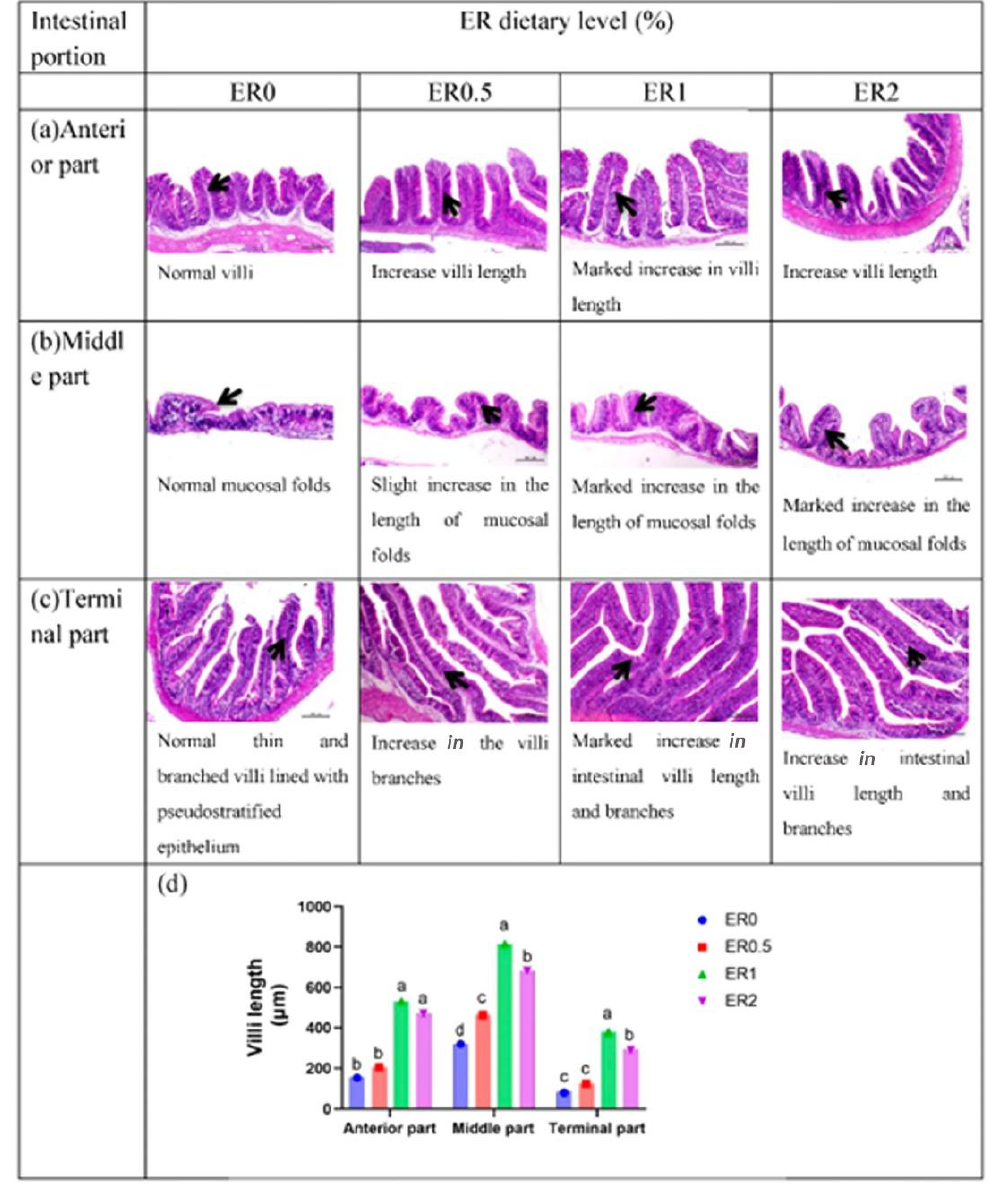
Figure 2. Photomicrographs of Red tilapia intestines fed different dietary levels of ER. ( a ) anterior part: scale bar is 100 µ m; ( b ) middle part: scale bar is 100 µ m; and ( c ) terminal part: scale bar is 100 µ m. ( d ) Intestinal villi length. Means with different letters are significantly different ( p <